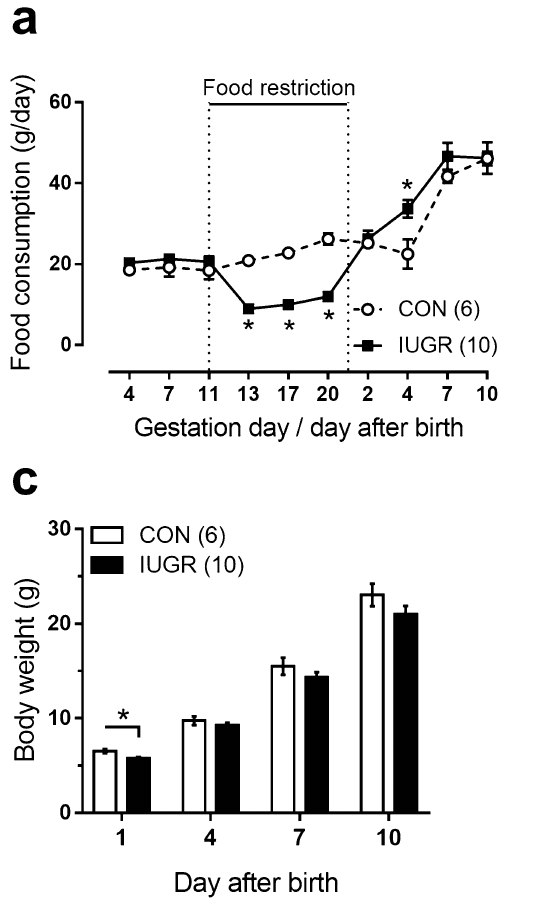
Figure 1. Food restriction during pregnancy (starting from the 11th gestational day till delivery) causes the decrease of dam body weight and the development of IUGR in their offspring. ( a , b ) Dam food consumption ( a ) and body weight ( b ) during gestation and first days after delivery in control and IUGR groups. ( c ) Pup body weight during first postnatal days in control and IUGR groups. Numbers in parenthesis indicate the number of females ( a , b ) or litters ( c ). *p < 0.05 (unpaired Student’s t